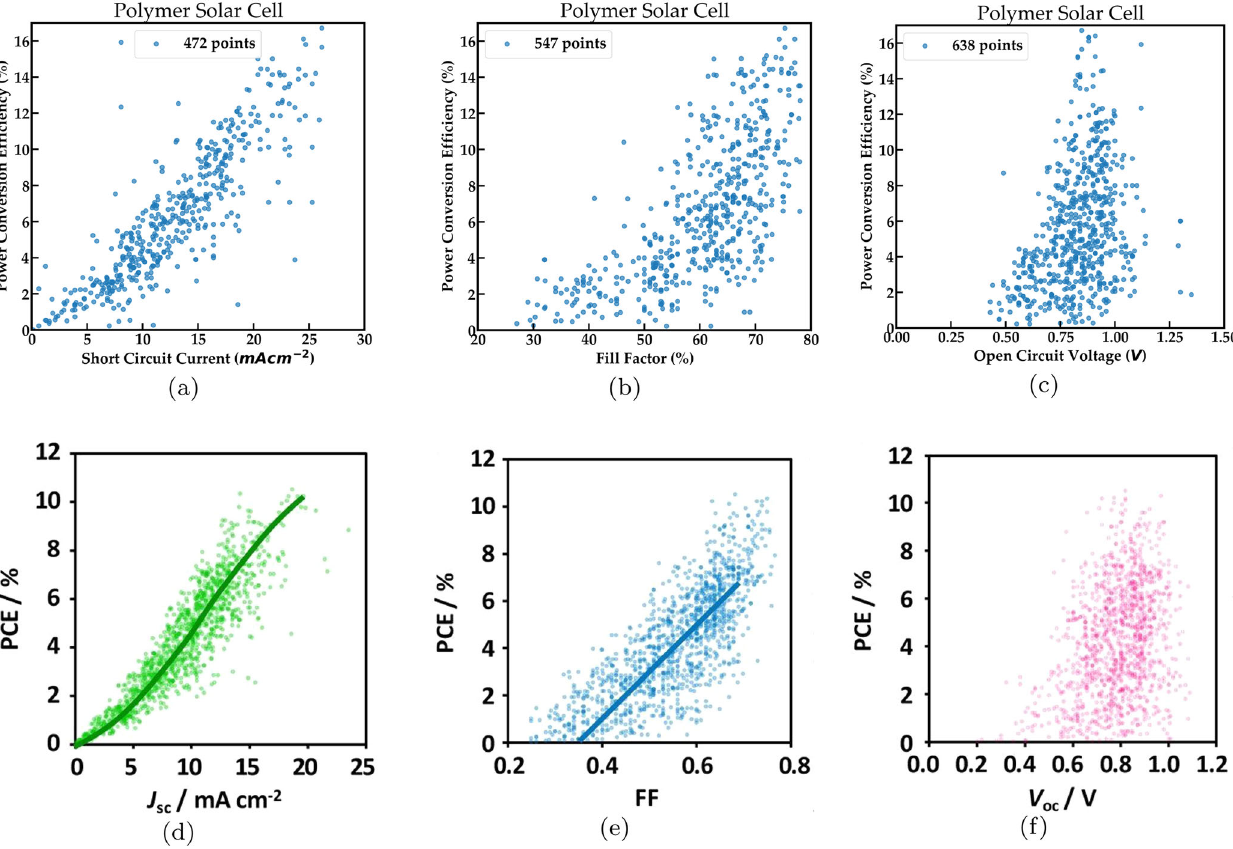
Fig. 5 Correlations between key properties extracted automatically from literature for polymer solar cells. a Power conversion ef fi ciency against short circuit current b Power conversion ef fi ciency against fi ll factor c Power conversion ef fi ciency against open circuit voltage. Correlations between key properties extracted manually from literature for polymer solar cells d Power conversion ef fi ciency against short circuit current e Power conversion ef fi ciency against fi ll factor f Power conversion ef fi ciency against open circuit voltage. Figure 5 d – f is adapted here with permission from Ref. 37 . Copyright 2018 American Chemical Society.